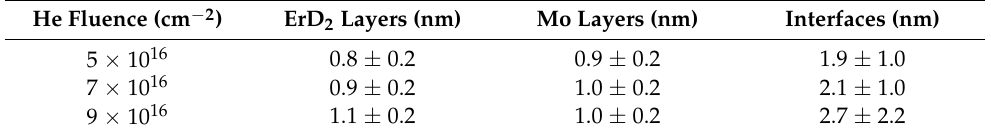
Table 1. He bubble size (diameter) measured during in-situ He implantation, as a function of fluence. He Fluence (cm − 2 )